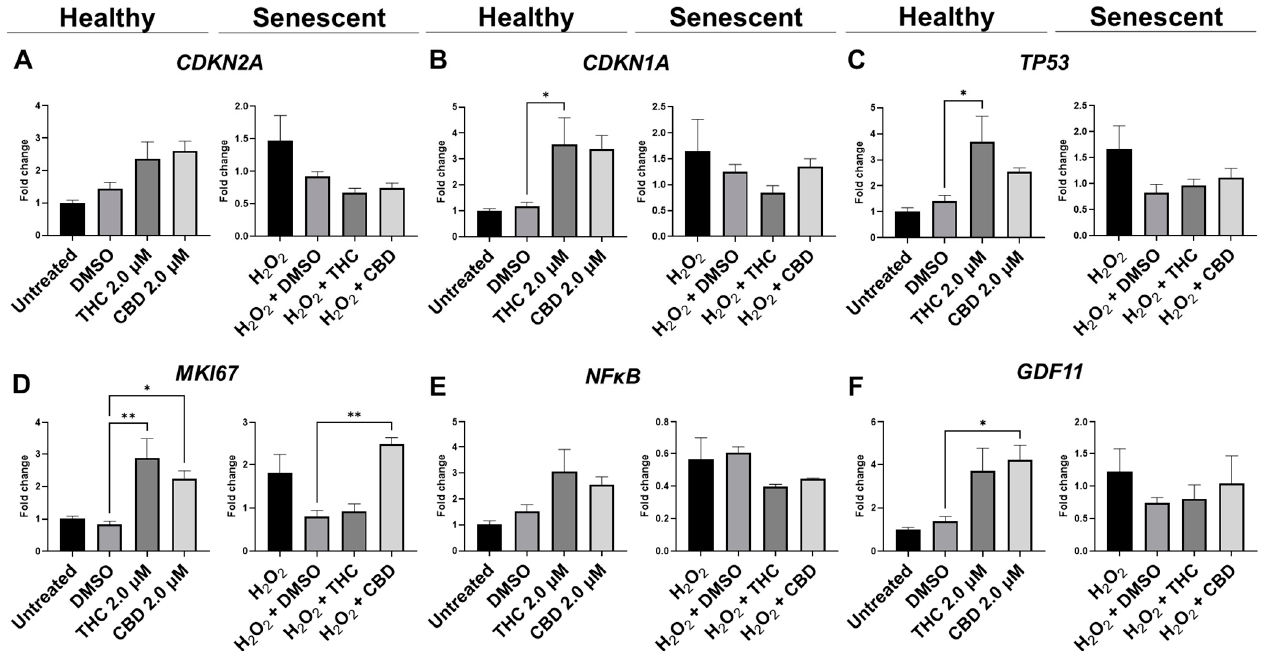
Figure 8. Effects of phytocannabinoids on mRNA levels of cell cycle regulators in CCD-1064Sk human dermal fibroblasts (PDL 24). mRNA levels were presented as a ratio of the target gene relative to GAPDH for expression of ( A ) CDKN2A , ( B ) CDKN1A , ( C ) TP53 , ( D ) MKI67, ( E ) NF- κ B , and ( F ) GDF11 . Data were analyzed with an ANOVA test followed by a Dunnett’s post-hoc multiple comparison test compared to the vehicle. Bars represent mean ± SEM, n = 3. Significance is indicated using the following scale: * p < 0.05, ** p < 0.01. CBD, cannabidiol; DMSO, dimethyl sulfoxide (vehicle);